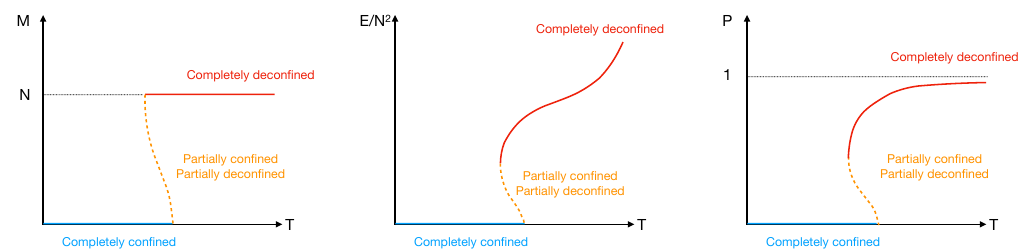
Figure 2. Sketches of the temperature dependence of M , E and P for the pure Yang-Mills theory. N 2 Blue, orange and red lines are completely-confined phase, partially-deconfined saddle (equivalently, partially-confined saddle) and completely-deconfined phase. The partially-deconfined saddle is the maximum of free energy at fixed temperature. See ref. [8] for other examples including a thermo- dynamically stable partially-deconfined